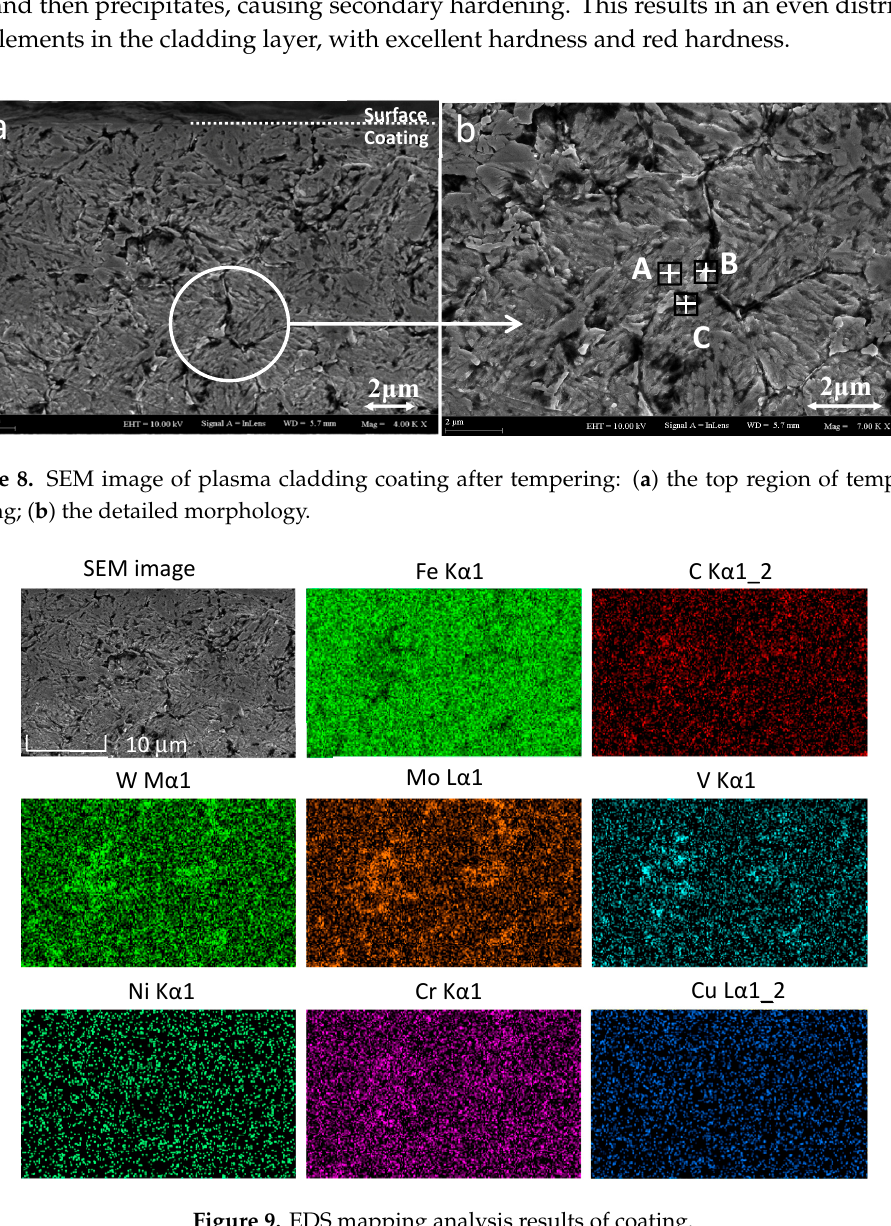
Figure 10. TEM image of plasma cladding coating and selective diffraction. A large amount of secondary carbides is dispersed and precipitated in the cladding layer. The shape of the carbides is granular and striped. As shown in Figure 10, combined with the results of selective diffraction, the granular particles are Mo2C carbide and the size is about 40 nm, which is coplanar with the martensite. The striped particles are VC carbide and the diameter is about 8 nm. Carbides are precipitated from austenite after cladding, and the austenite is cooled and transformed into martensite.